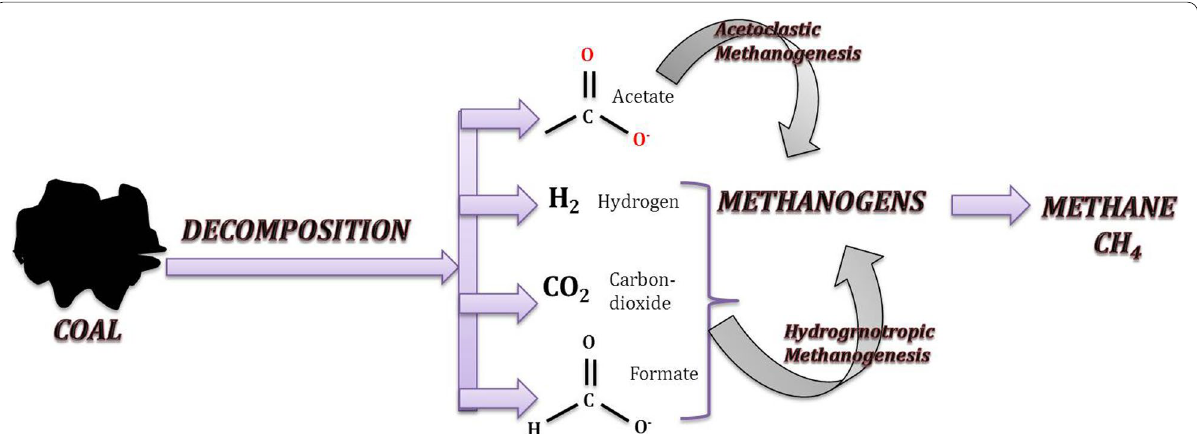
Fig. 1 Pictorial representation of microorganism interactions in the bio-conversion process of coal to